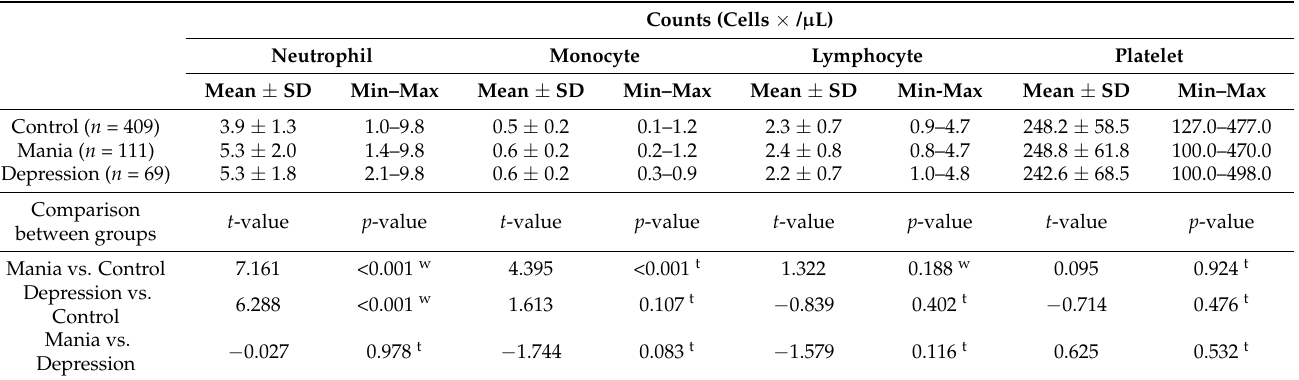
Table 2. White blood cells and platelets distribution per